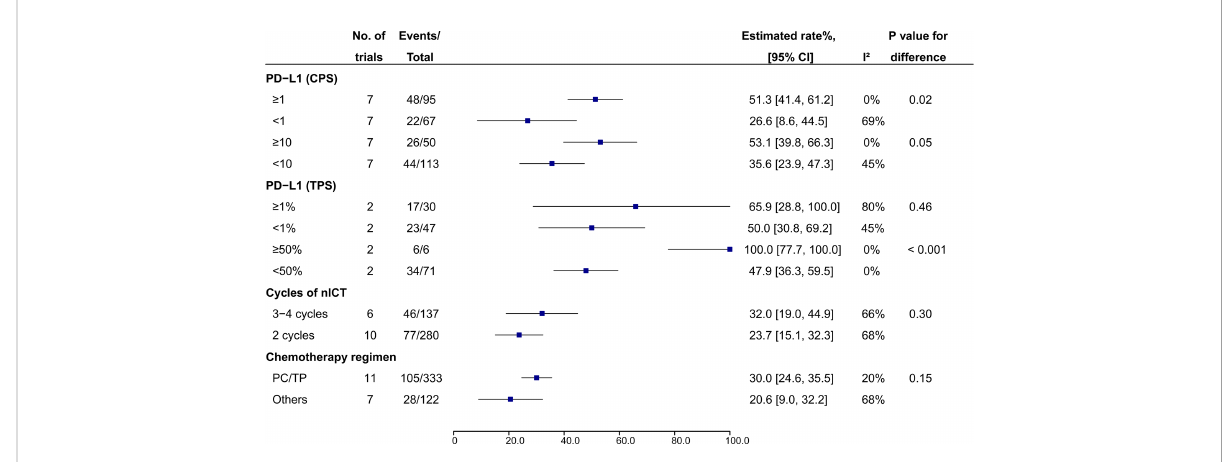
FIGURE 5 Subgroup analysis of pCR rate in patients receiving nICT. nICT, neoadjuvant immune checkpoint inhibitor in combination with chemotherapy; PC/TP, paclitaxel plus carboplatin or